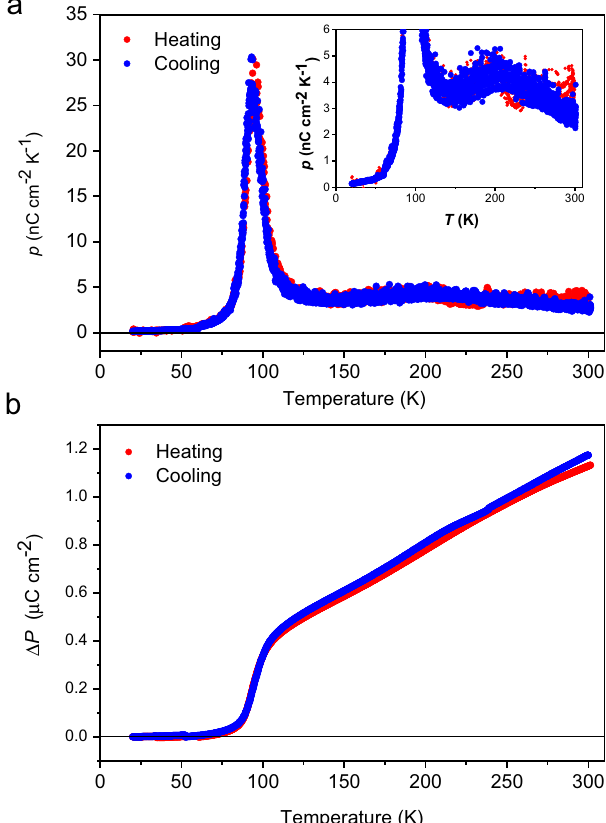
Fig. 3 Pyroelectric properties of the [FeCo] crystals. a Temperature dependence of the pyroelectric coef fi cient for 1(PF 6 ) 3 . Pyroelectric coef fi cients are almost constant at approximately 2.4 − 5.0 nC cm − 2 K − 1 between 300 and 120K. Sharp peaks are obtained on both cooling and heating modes at ca. 90